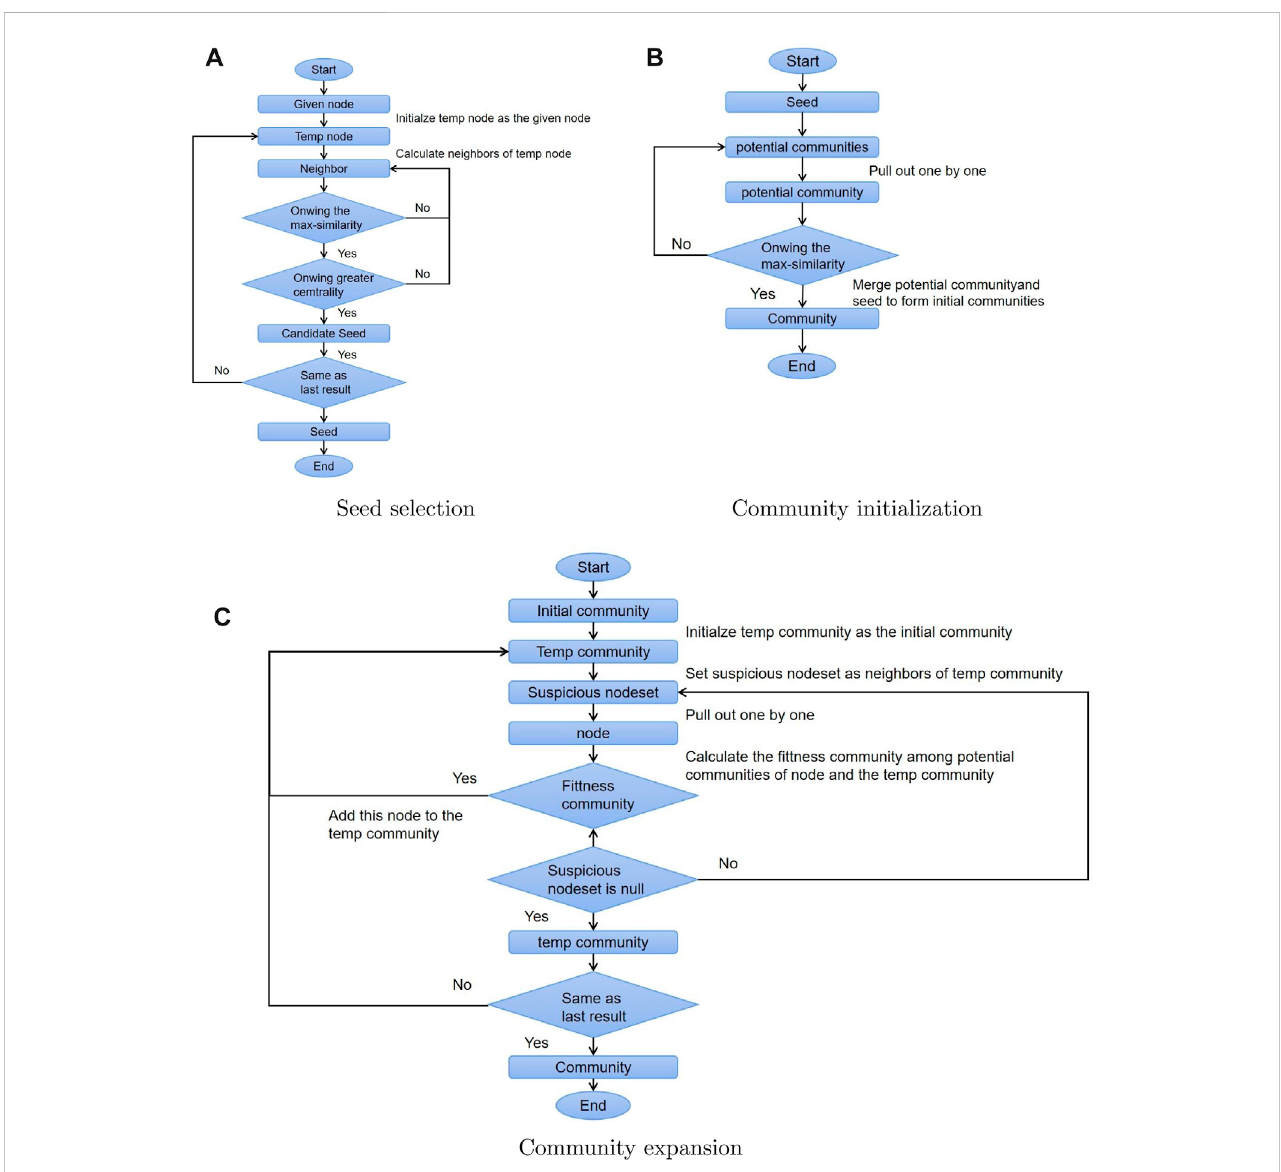
FIGURE 5 The fl ow chart of LCDPC s. (A) The fl ow chart of seed selection process. (B) The fl ow chart of community initialization process. (C) The fl ow chart of community expansion